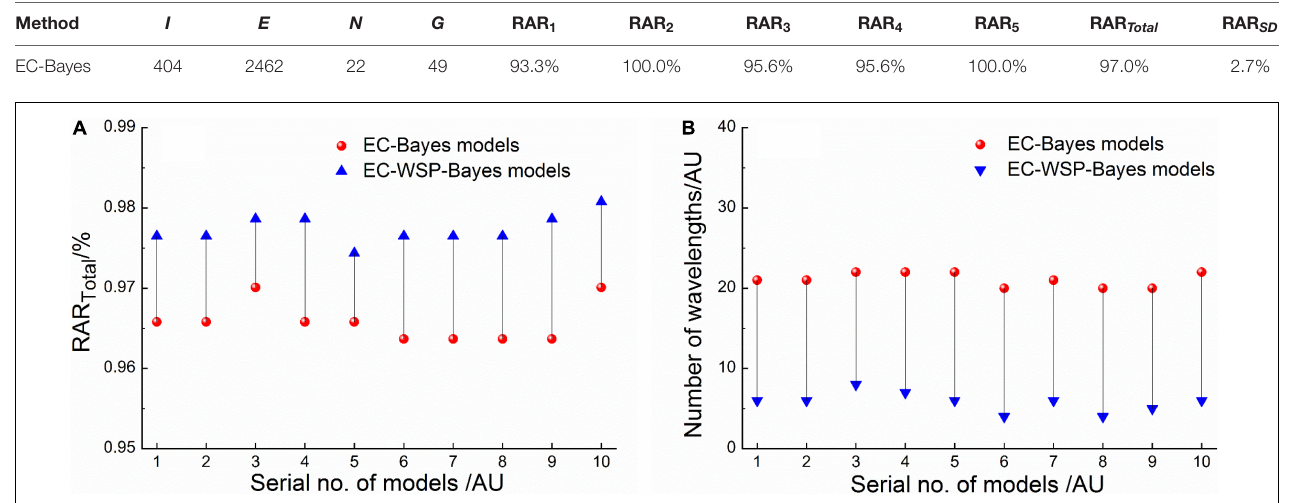
FIGURE 3 | Comparison of the top 10 equidistant combination (EC)-Bayes models and corresponding EC-wavelength step-by-step phase-out (WSP)-Bayes models: (A) RAR Total ; (B) number of wavelengths.